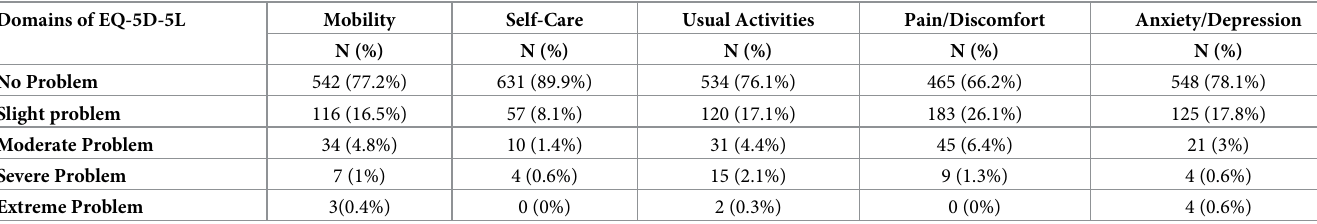
Table 3. Self-reported problems by patients suffering from Rheumatic Fever and Rheumatic Heart Disease in five domains of EQ-5D-5L. Domains of